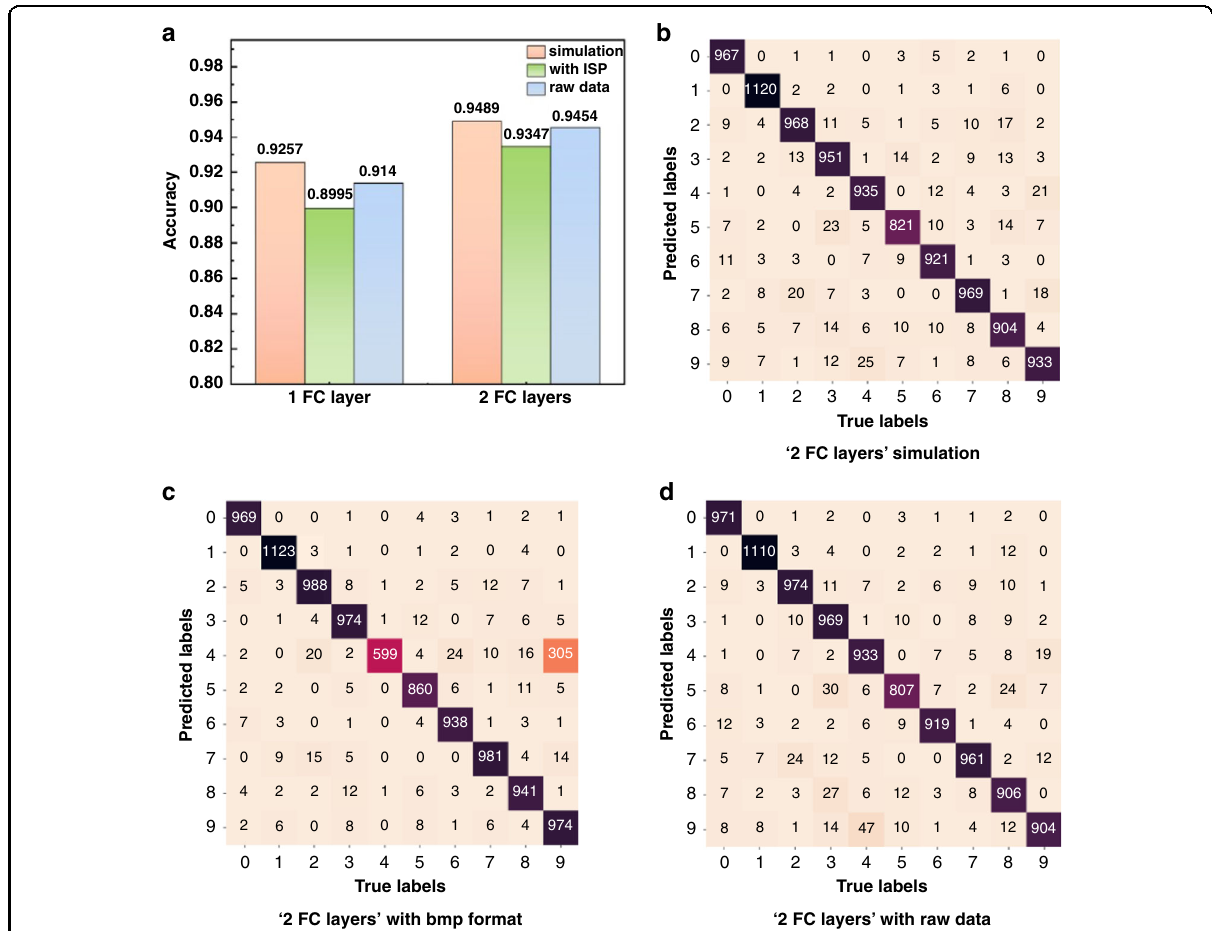
Fig. 6 Results for single-kernel system. a Experimental recognition accuracy with or without ISP. The feature size was set to 40 μ m, and the objects were pre-compensated. b – d Confusion matrixes for 2 FC layers based on b simulation, c bmp format data, and d raw data,